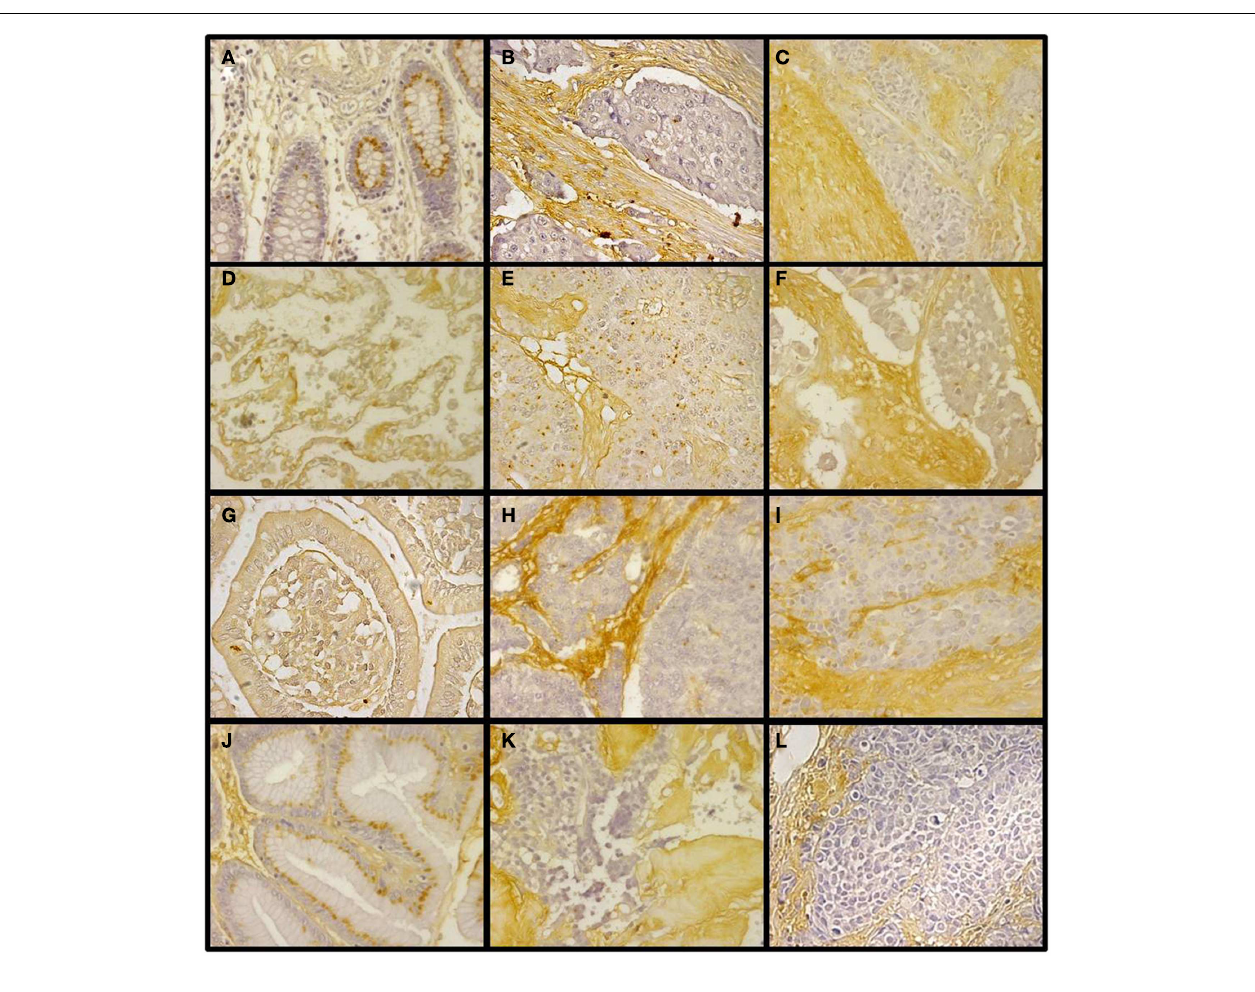
(I) , and pancreas (L) . Normal tissue samples displayed faint stromal staining, also present in isolated intestinal epithelial cells (A,D,G,J) ; well-differentiated NETs showed focal stromal staining (B,E,H,K) , clearly enhanced in the cases of poorly differentiated tumors (C,F,I,L) . Magnification 400 ×